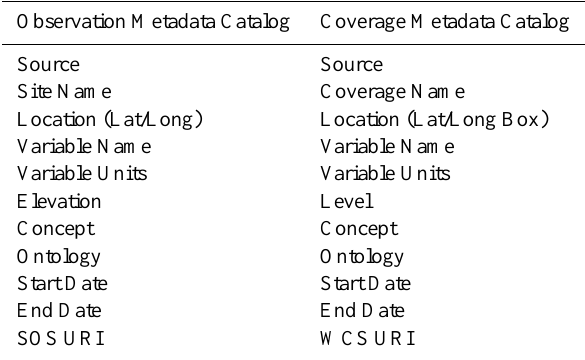
Table 1. Condensed CUAHSI-HIS metadata